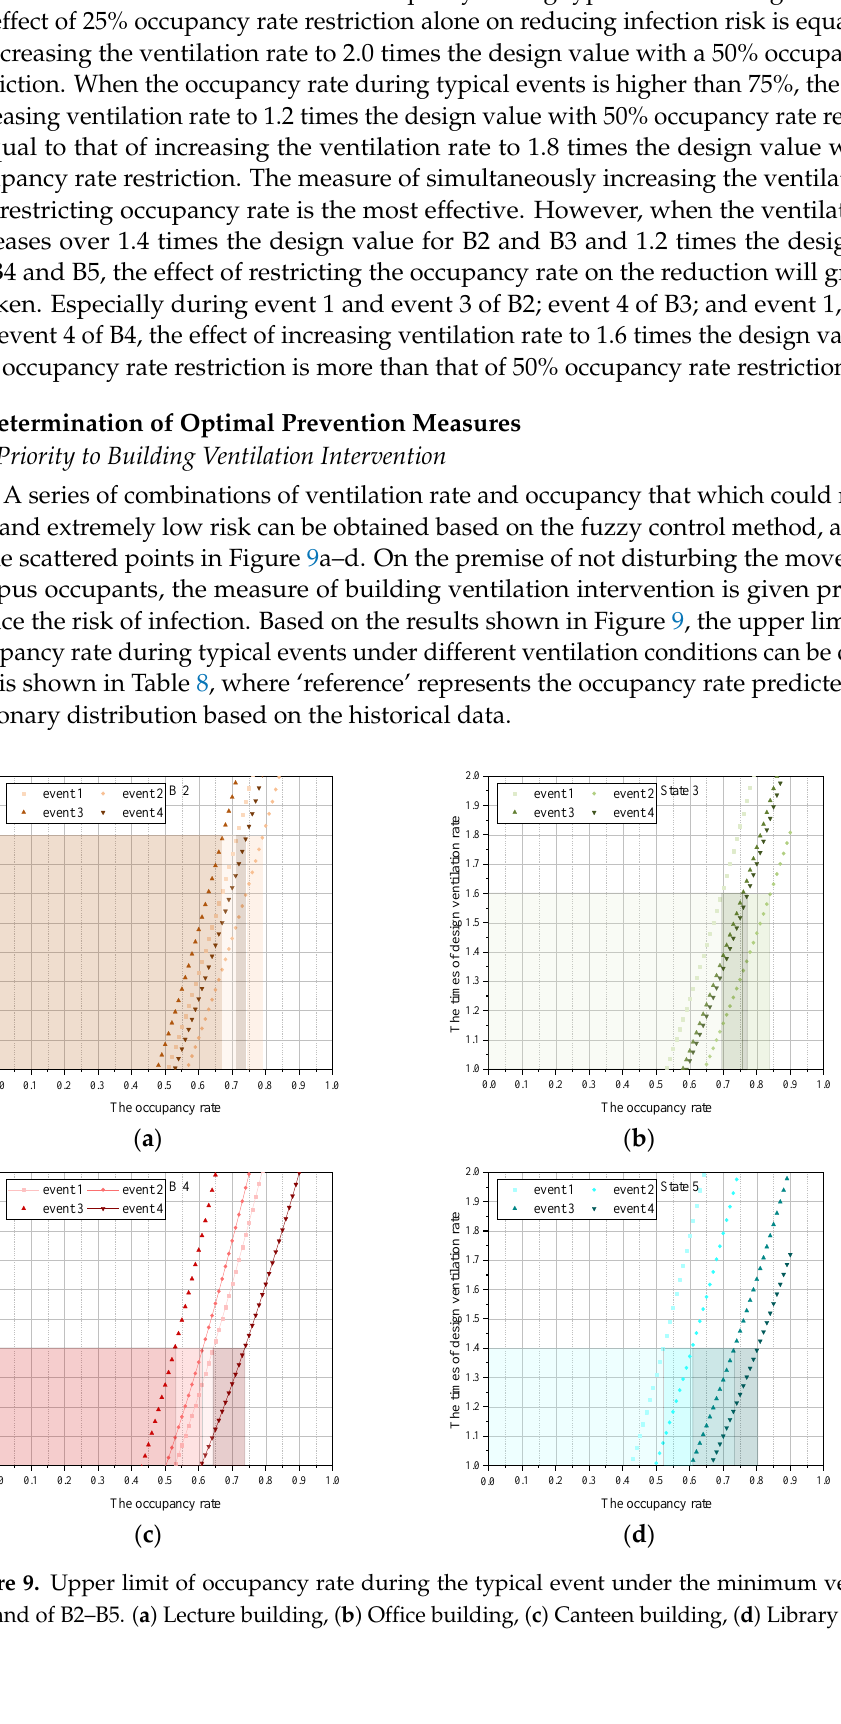
Table 8. The upper limit of occupancy rate during typical events under different ventilation rates.